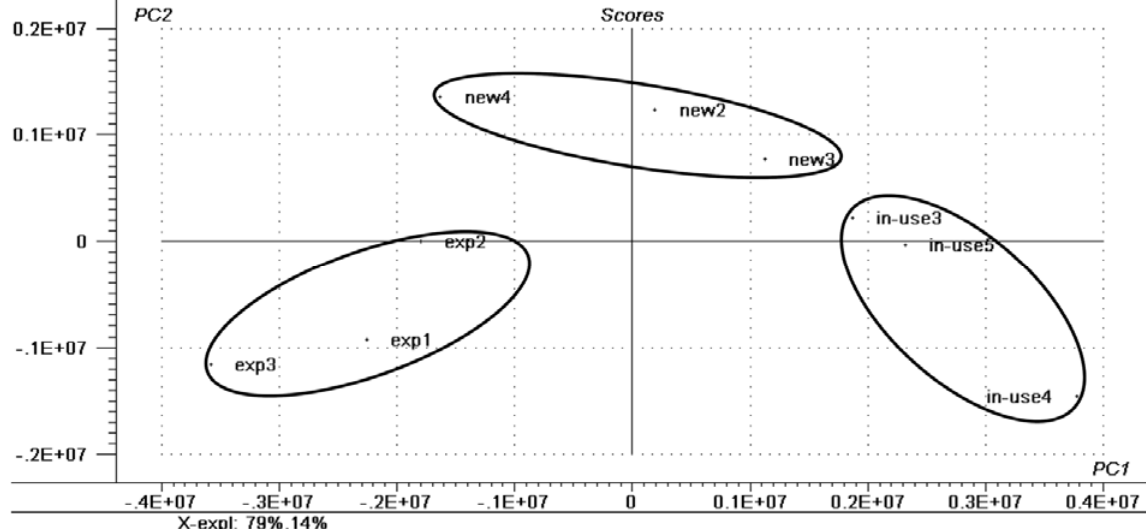
Figure 3. Score plots of the eyeliner sample groups. The groups are represented as “exp” for expired samples, “new” for new samples and “in-use” for used samples.